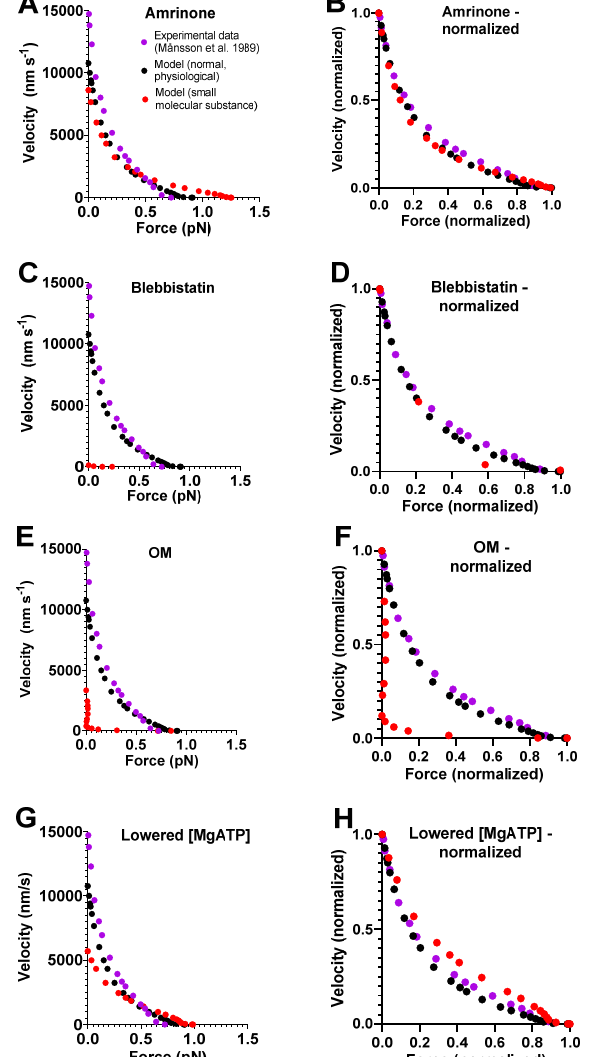
Figure 2. Force–velocity data simulated using the model in Figure 1 with standard parameter values (Tables 1 and 2). ( A ) Simulated data from model under standard conditions (black) and modified conditions (as described in text) to account for the effects of 1–2 mM amrinone (red). The modeled data are compared to experimental FV data (purple) from [13] in the absence of any myosin- modifying compound. Maximum force given in pN per available cross-bridge (whether attached or not) for model data, whereas the maximum force for experimental data is normalized to exhibit the same maximum force as the model. ( B ) Data from A replotted after normalizing both force and velocity to maximum value under each condition. ( C ) Simulated data from A, but red symbols correspond to the effects of saturating the concentration of blebbistatin. ( D ) Data from C replotted after normalizing both force and velocity to maximum value under each condition. ( E ) Simulated data from A but red symbols correspond to effects of saturating concentration of OM. ( F ) Data from E replotted after normalizing both force and velocity to maximum value under each condition. ( G ) Simulated data from A, but red symbols correspond to effects of reducing [MgATP] from 5 mM to 100 µ M. ( H ) Data from G replotted after normalizing both force and velocity to maximum value under respective